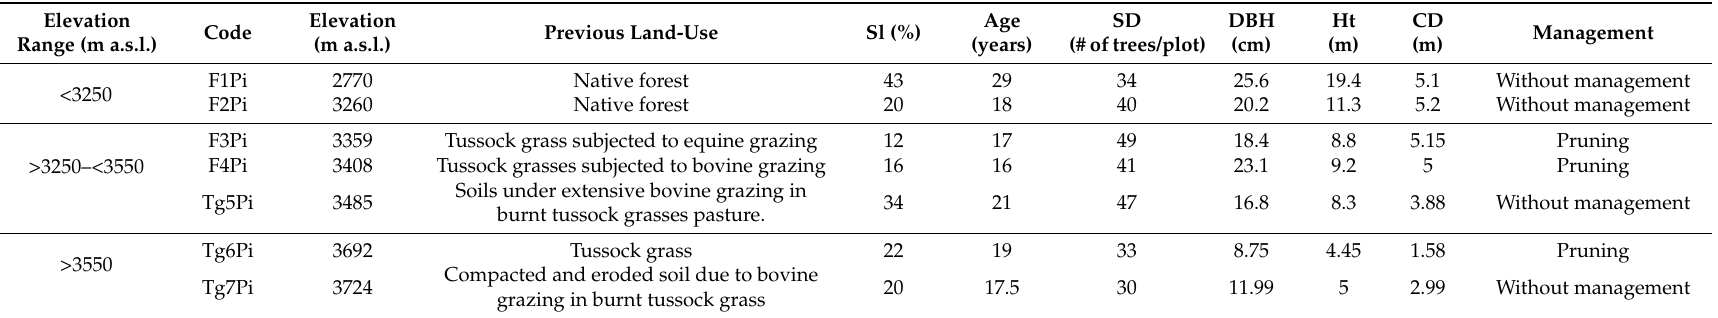
Table 1. General description and median values of the dendrometric variables in the pine plantations (Azuay province, southern Ecuador). Elevation Range (m a.s.l.)